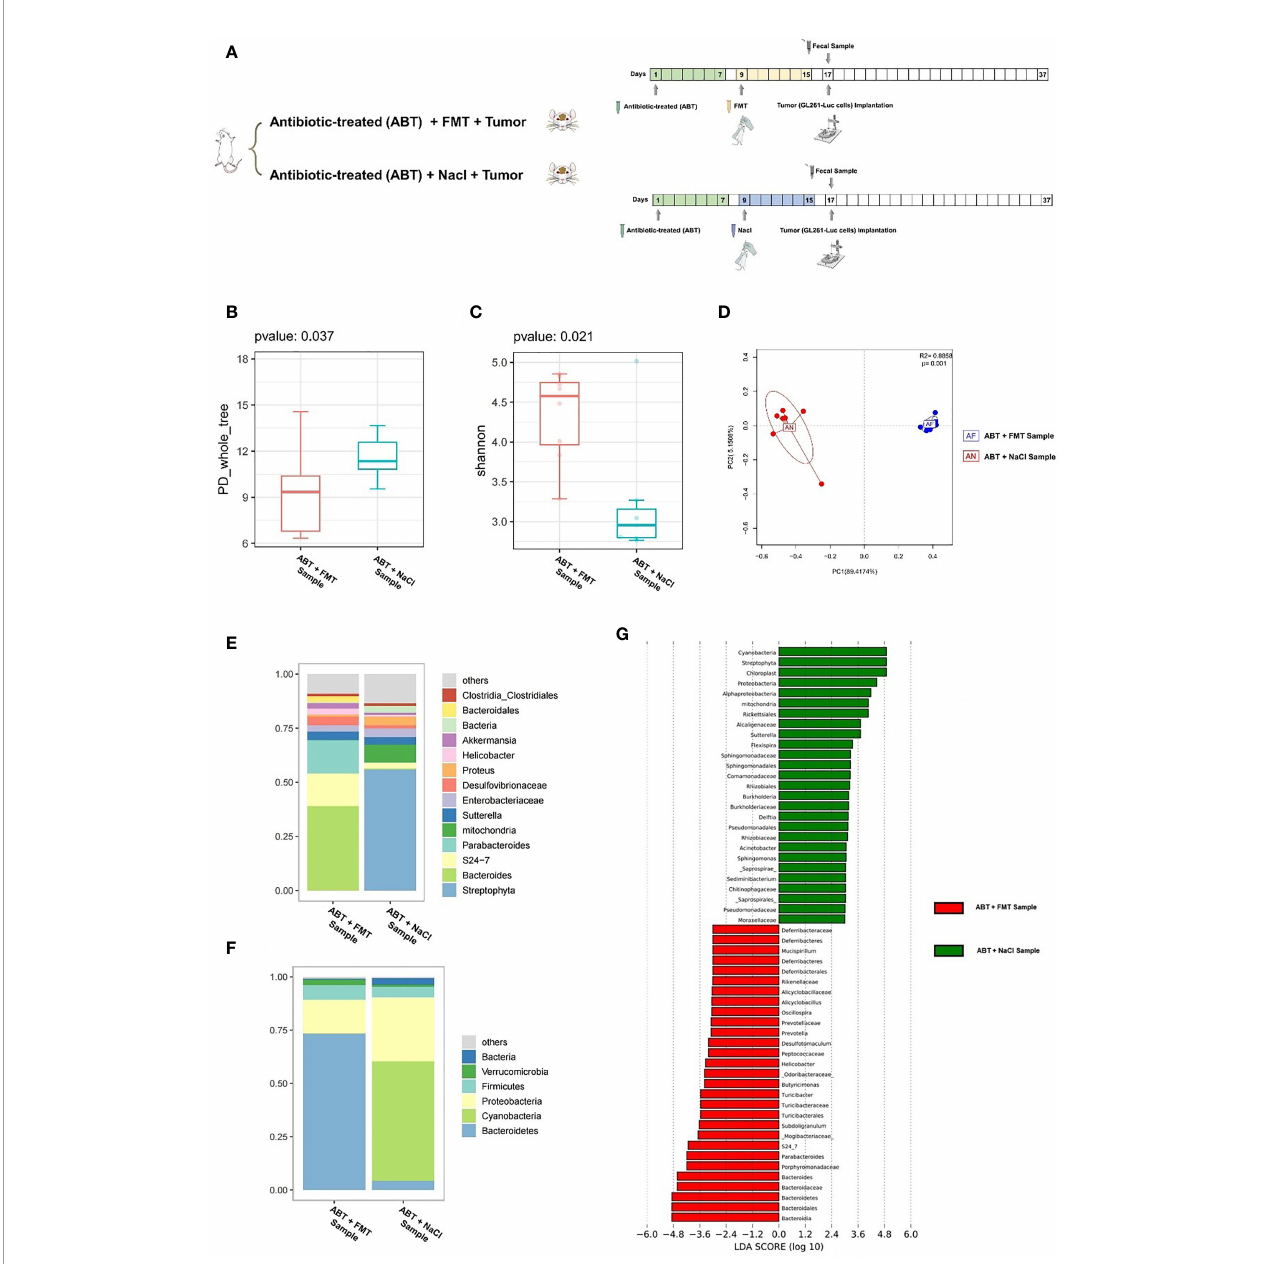
FIGURE 4 | (A) Experimental design and stool sample collection (third part). (B – G) Comparison between the sample of fecal microbiota transplantation after antibiotic treatment (ABT+FMT) and the sample of intragastric administration with physiological saline after antibiotic treatment (ABT+NaCl). (B) The